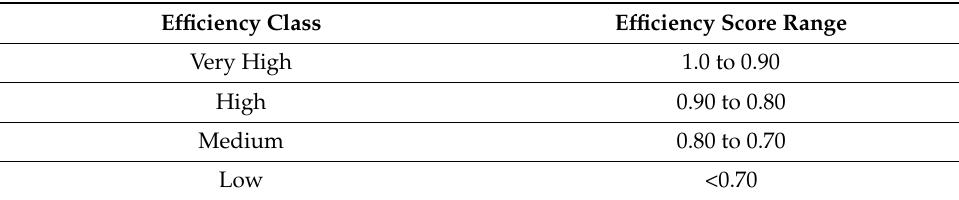
Figure 1. Systemic workflow of the research paper. Table 1. Efficiency group cut-offs in Stochastic Frontier Analysis.